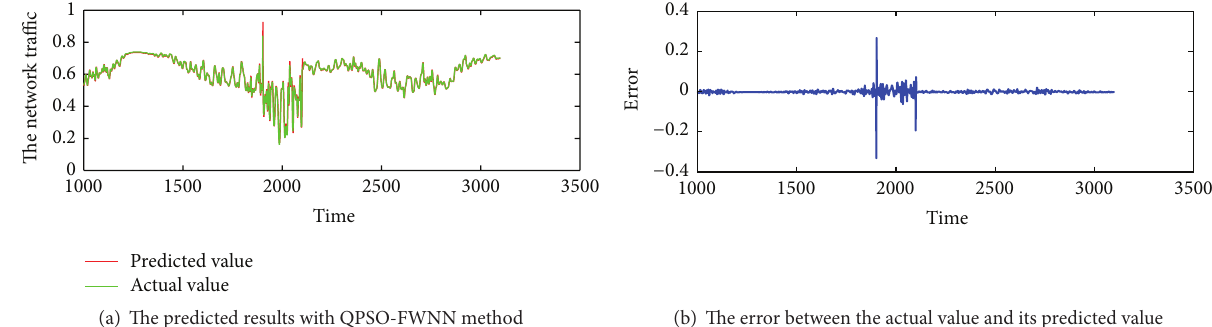
Figure 5: Prediction with QPSO-FWNN model.